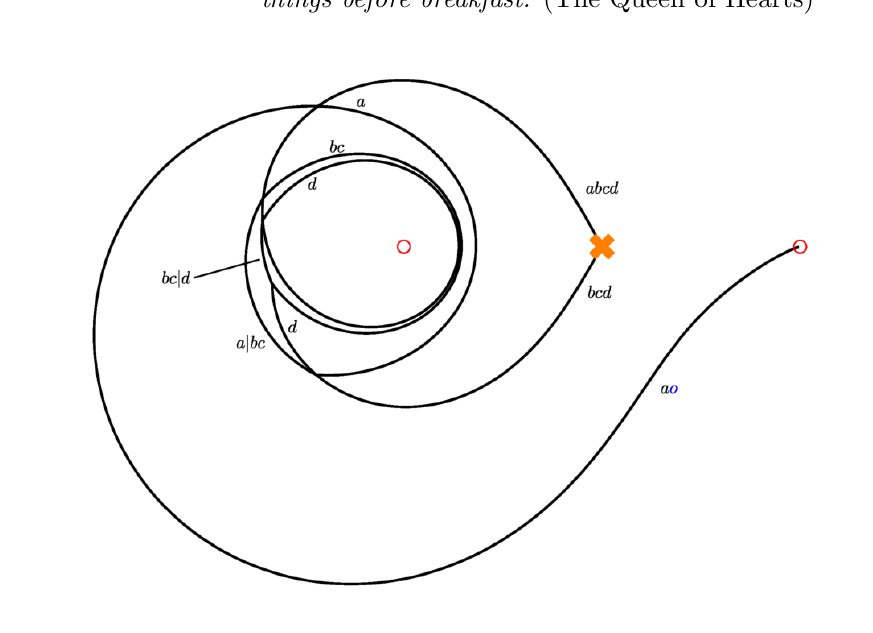
Figure 59. D4 + 4D0, corresponding to the partition (2,2).